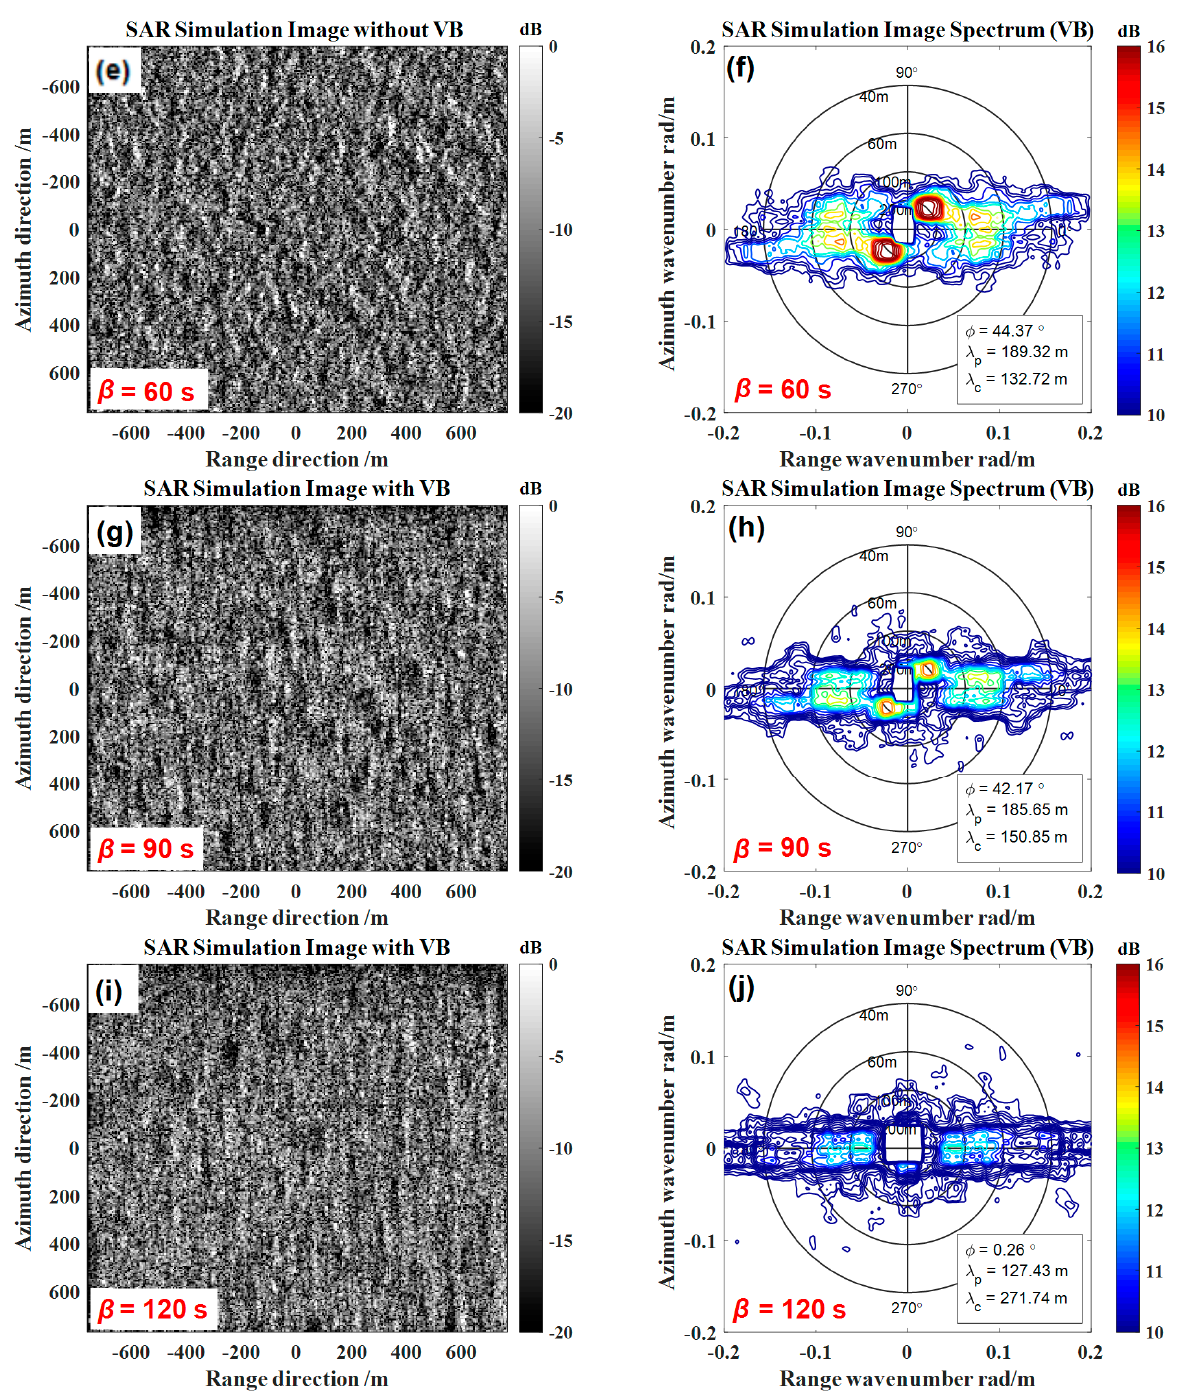
Figure 7. The simulated sea surface profile and corresponding SAR images with different β values. ( a ) The sea surface profile; ( b ) corresponding sea surface power spectrum; ( c ) β = 60s, v r = 0m/s, ( e ) β = 60s, ( g ) β = 90s, and ( i ) β = 120s; ( d , f , h , j ) are the corresponding SAR image